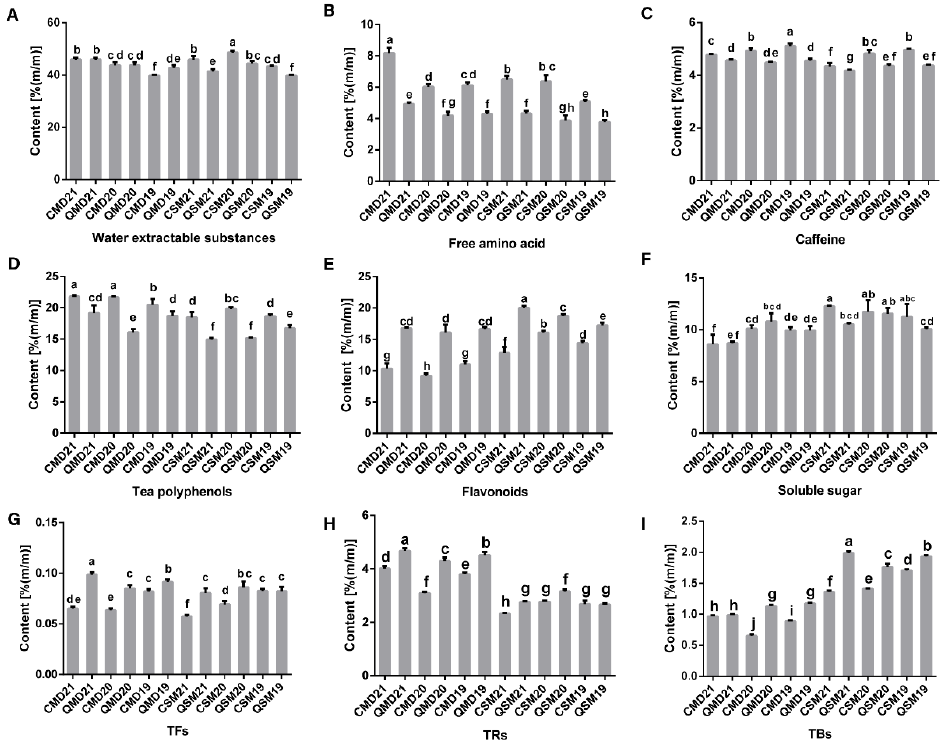
Figure 3. The content of ( A ) water-extractable substances, ( B ) free amino acids, ( C ) caffeine, ( D ) tea polyphenols, ( E ) flavonoids, ( F ) soluble sugar, ( G ) TFs, ( H ) TRs, and ( I ) TBs. The various